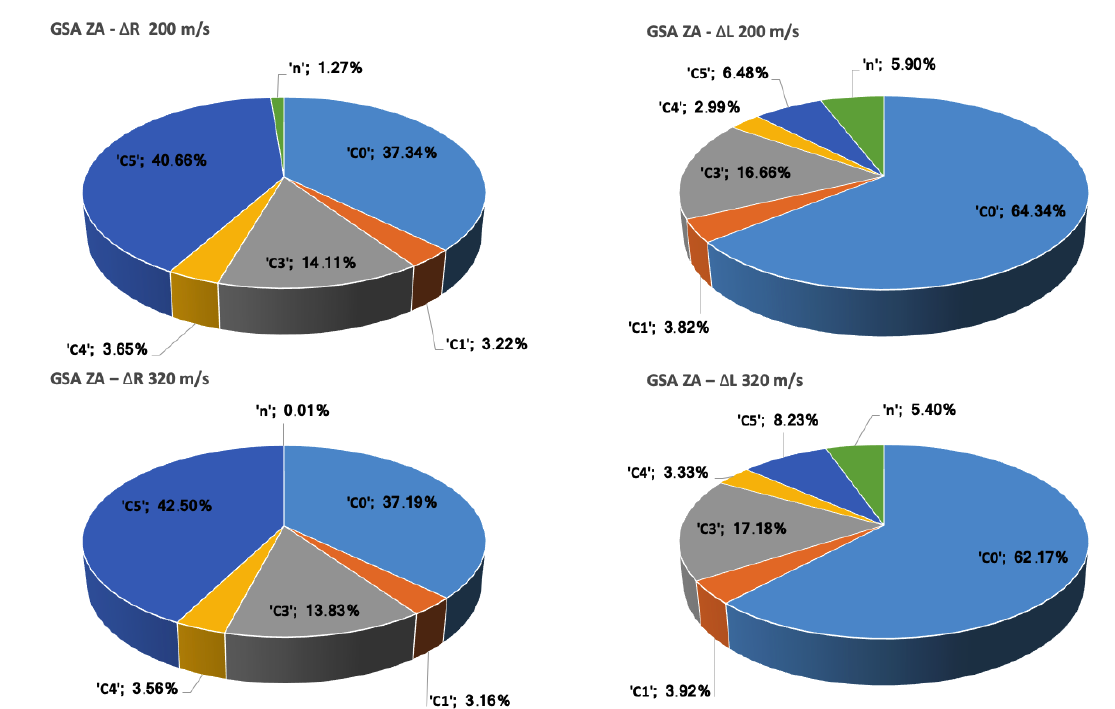
Figure 8. GSA results for the Zerilli–Armstrong (ZA) model considering ∆ R and ∆ L at 200 and 320 m/s.